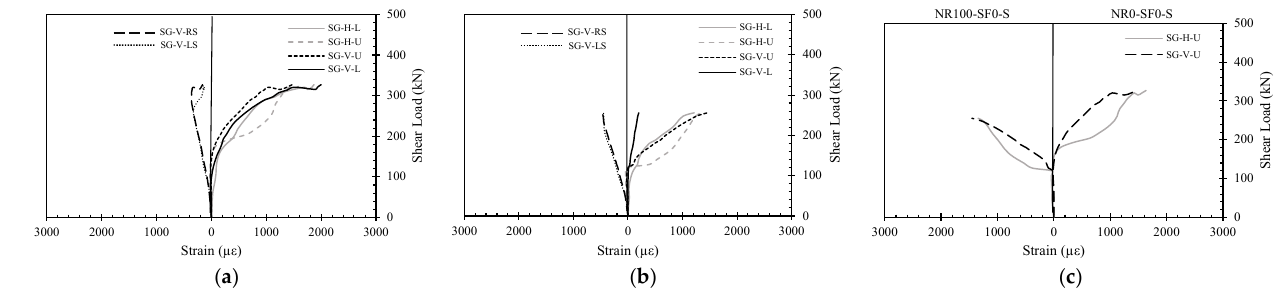
Figure 16. Numerical stirrup strain response of group N: ( a ) NR0-SF0-S; ( b ) NR100-SF0-S; and ( c ) horizontal versus vertical stirrup strain responses in the upper chord.